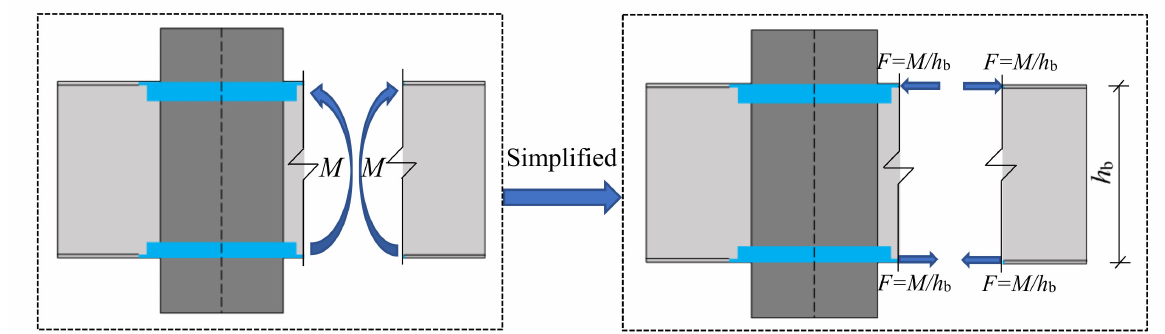
Figure 13. Schematic diagram of the simplified process of the